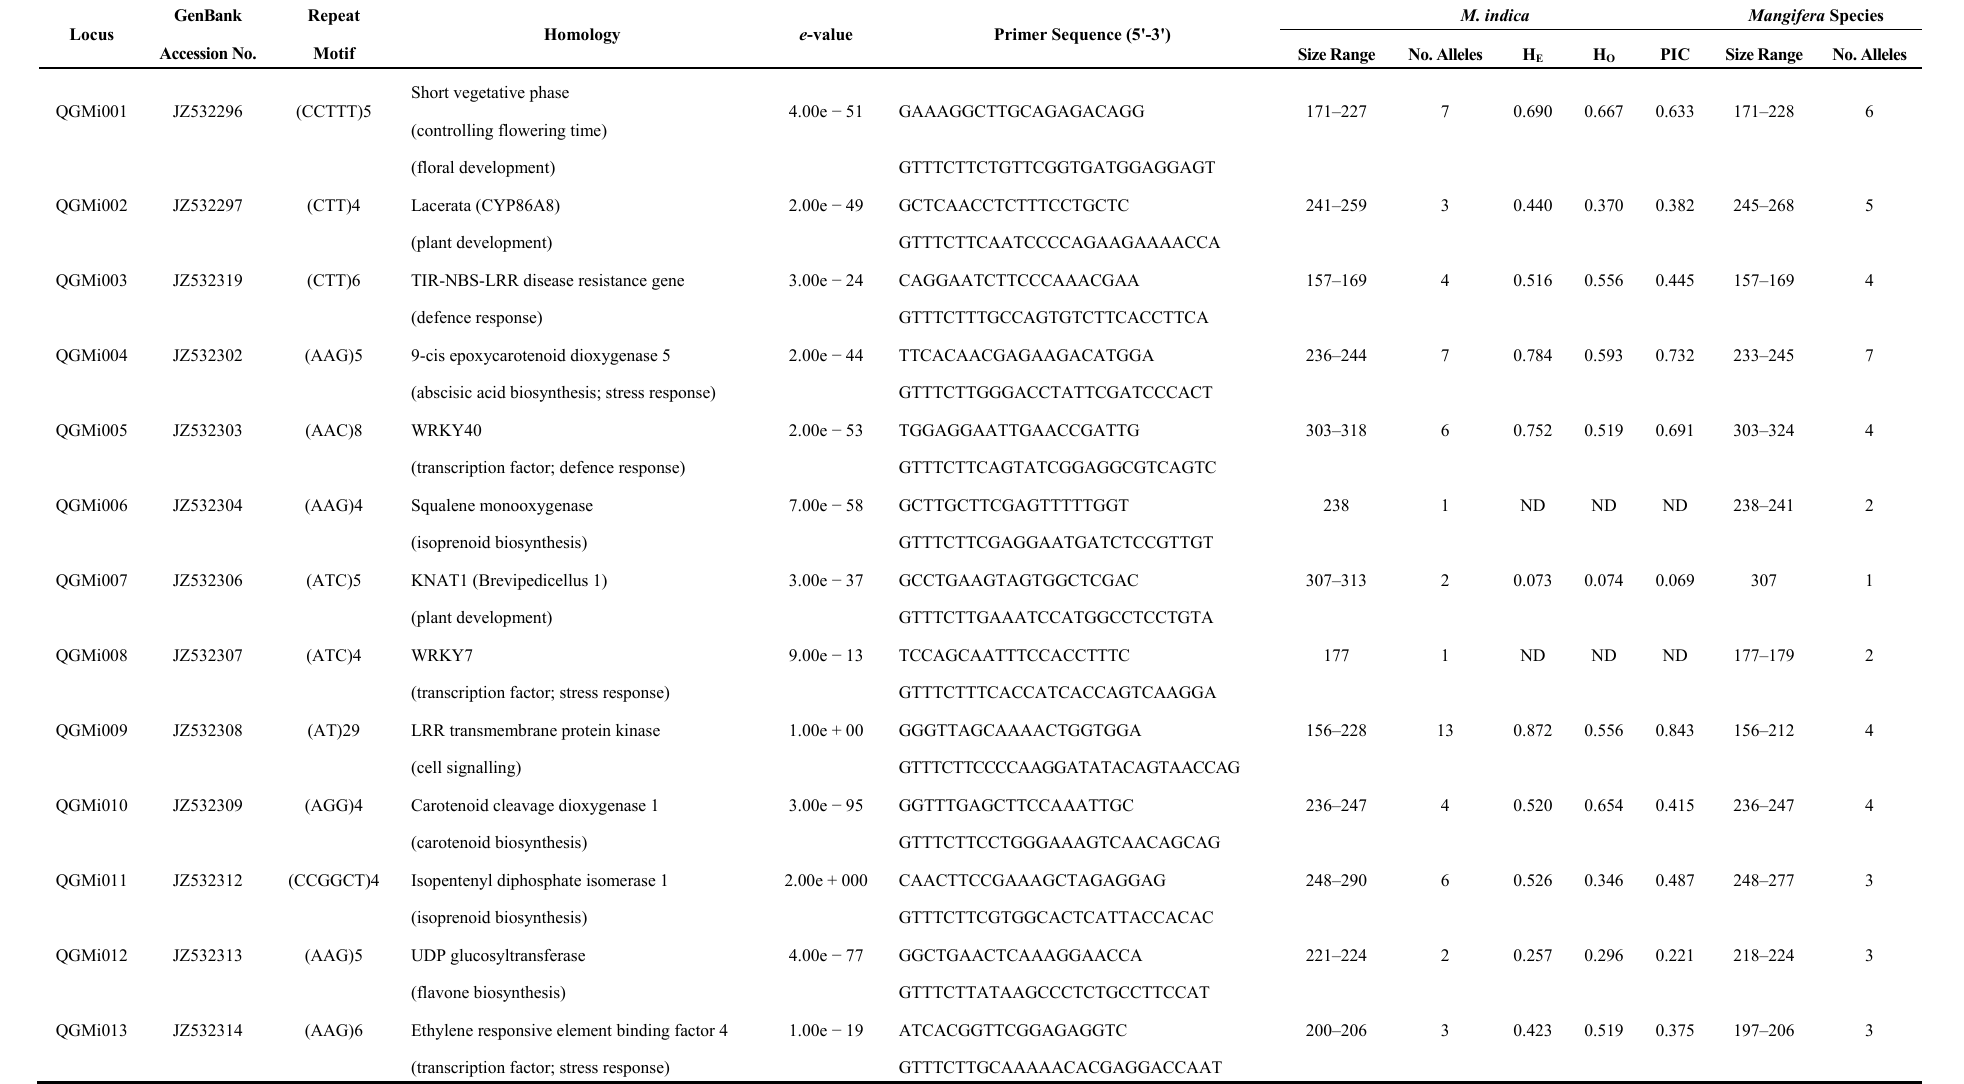
Table 3. Characteristics of 25 EST-SSR markers screened across 27 varieties of M. indica and five Mangifera